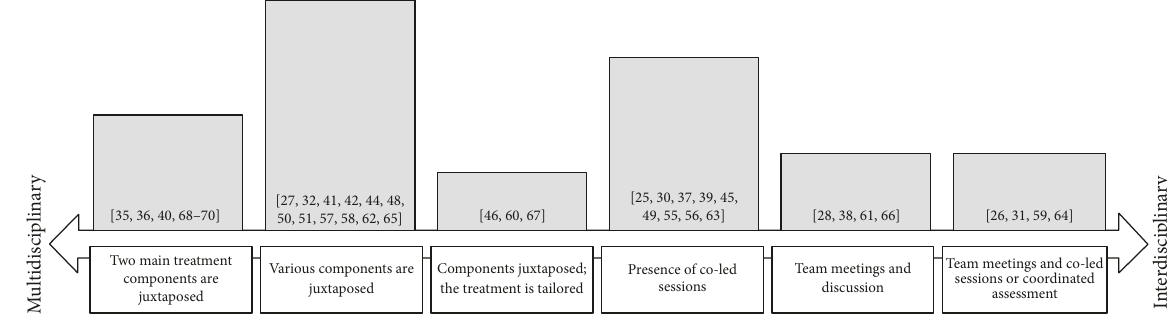
Figure 2: Map of the rehabilitation programs. Note . The height of the bars is proportional to the frequency of the interventions included in the relative category. The references of the studies describing these interventions are in